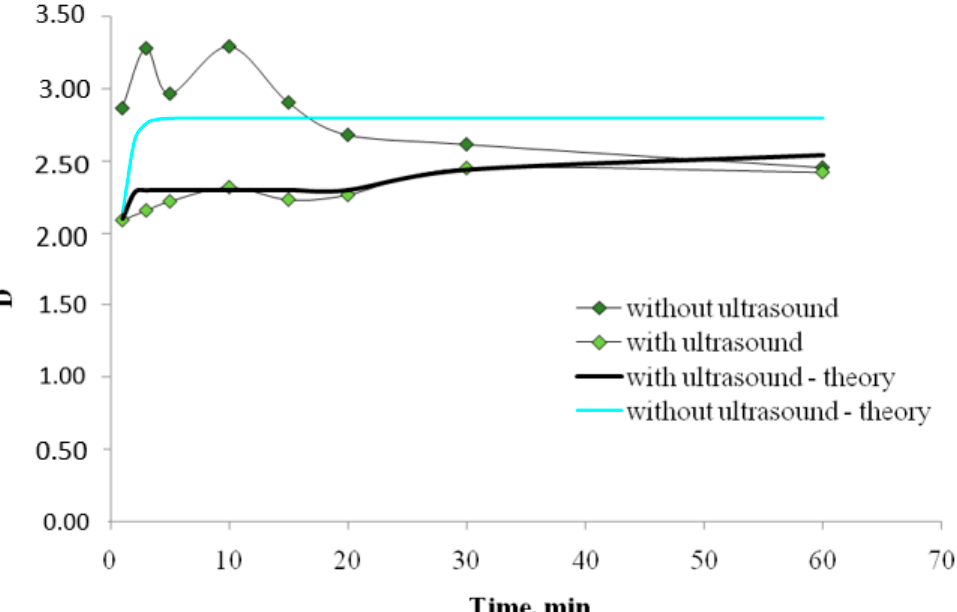
Figure 4. Diagram of the interaction of a protonated polymer molecule with an anionic iron complex under ultrasound conditions and without ultrasound. The slowing down effect of metals extraction, discussed earlier in the literature [11], has now not only the clear physical explanation and justification, but is provided also with the effective tool